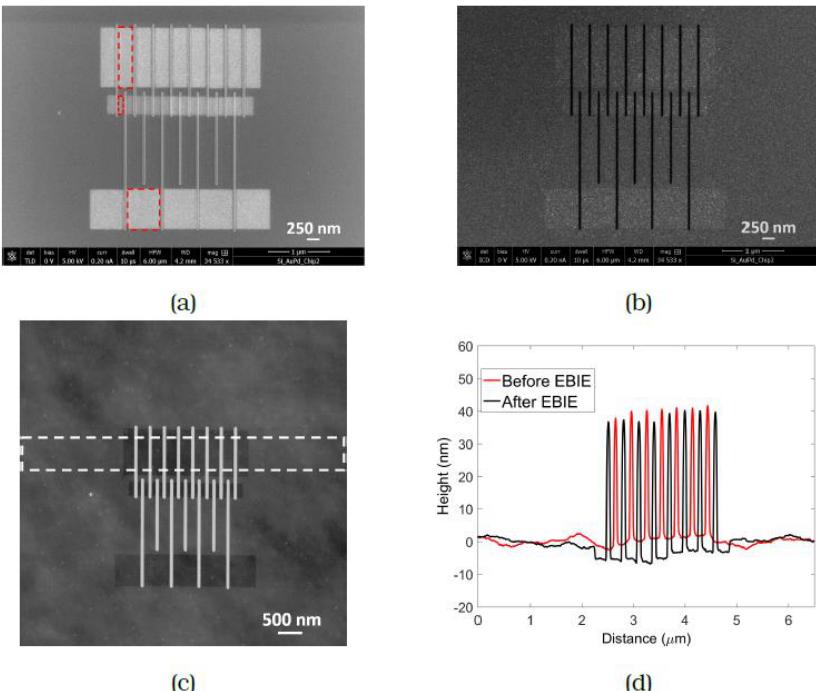
Figure 6. Backscattered electron (BSE) image of the array, also displaying a change in signal from the etched region. The thickness of the carbon film removed is reflected in the BSE contrast even for as little as 1 nm, meaning that BSE imaging would be a good method to monitor height changes. This is especially useful for lines at smaller spacing where height measurement of interconnecting material by AFM would not be accurate. Recipe 2: High resolution FEBIE in between FEBID lines